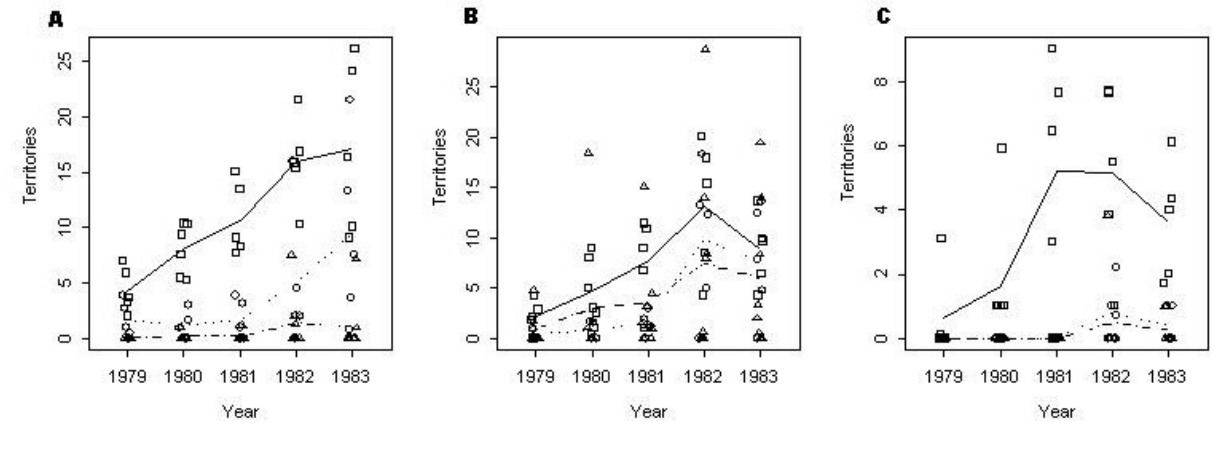
Fig. 4 . Number of territories of (A) Bay-breasted Warbler ( Dendroica castanea ), (B) Tennessee Warbler ( Vermivora peregrina ), and (C) Cape May Warbler ( Dendroica tigrina ) in young stands (triangles represent plots , dashed line represents mean), intermediate-aged stands (circles represent plots, dotted line represents mean), and mature stands (squares represent plots, solid line represents